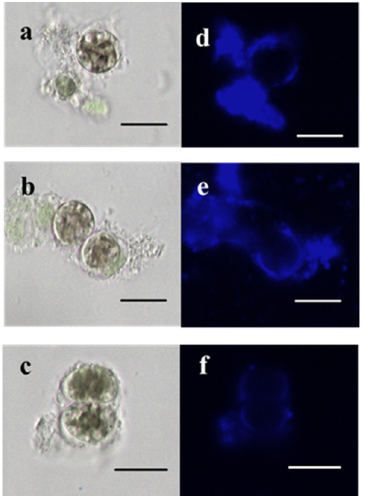
Figure 4. Detection of protoplasts by Evans blue staining. Dead protoplasts or cell fragments were stained by Evans blue. The survival rate of protoplasts was determined after Evans blue staining.